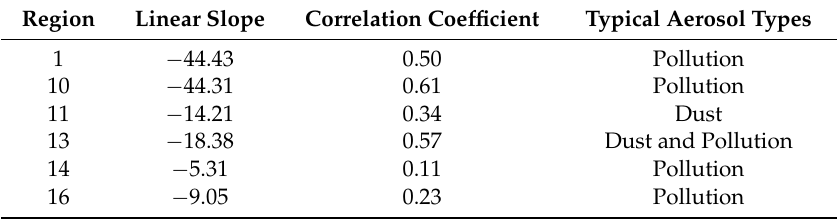
Table 2. The linear correlation slope and correlation coefficient for the six coastal oceanic regions with evident negative correlation between AOT and CDER among the 21 regions selected for AIE regional survey study. The typical aerosol types in the six regions are also listed in the last column.